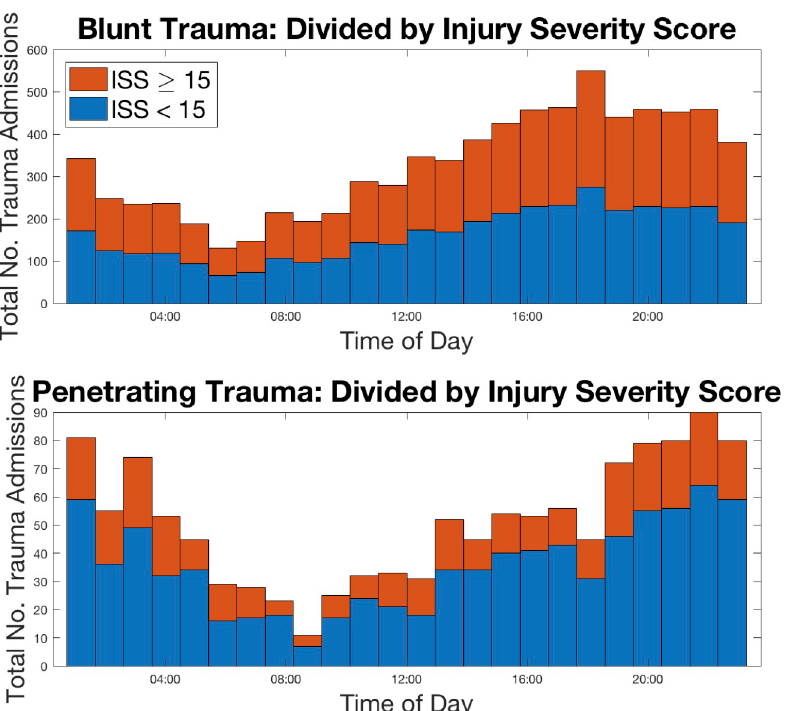
Fig 3. Absolute frequency of trauma admissions versus time of day partitioned by blunt and penetrating and divided by injury severity score.